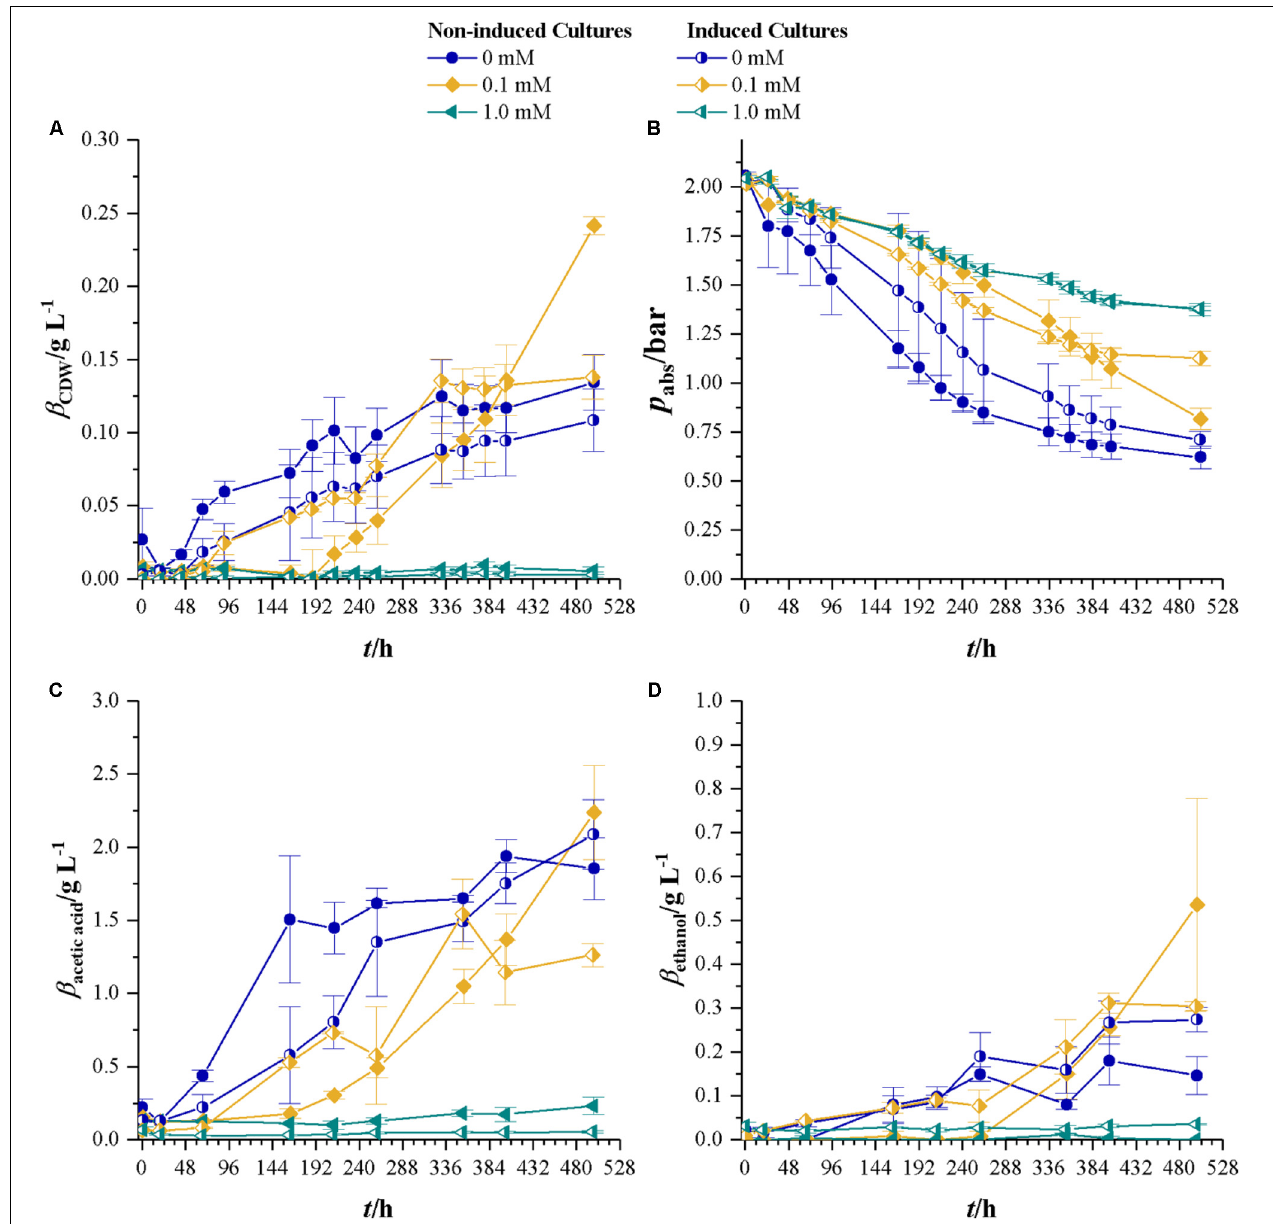
FIGURE 5 | Non-induced C. ljungdahlii (full symbols) vs. the induced strain (half-filled symbols) at different cyanide concentrations with syngas as a carbon and energy source. Cyanide concentrations are 0 (blue dots), 0.1 (yellow diamonds), and 1.0 mM (petrol tilted triangles). (A) CDW; (B) mass concentration of fructose; (C) mass concentration of acetic acid; and (D) mass concentration of ethanol. Average values of three independent cultivations. Average data from triplicate